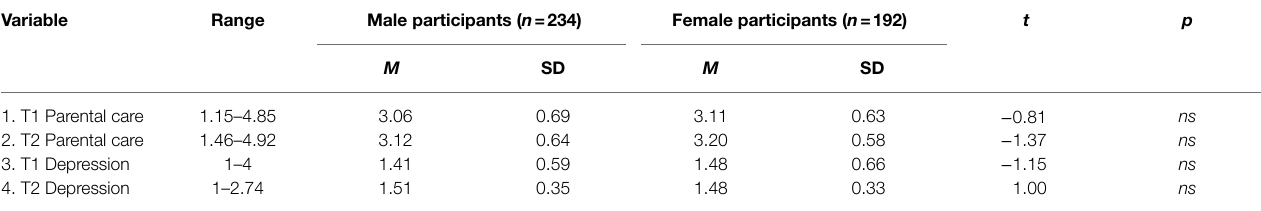
TABLE 2 | Descriptive analysis between male and female participants. Variable